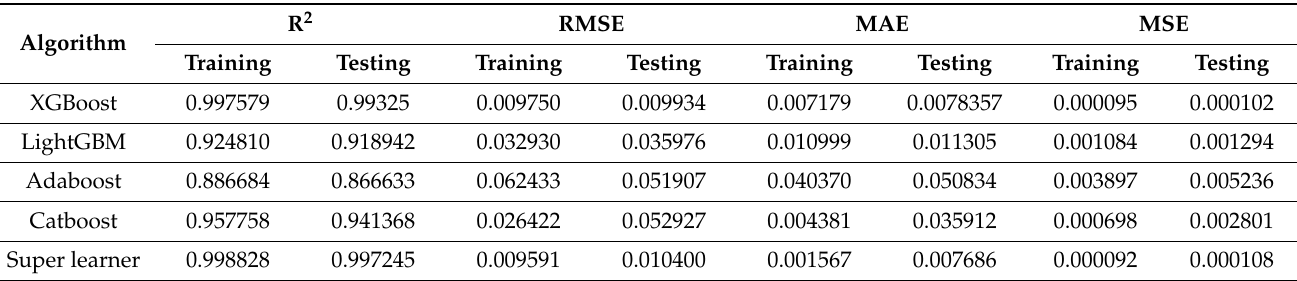
Table 3. Evaluation metrics summary for dataset